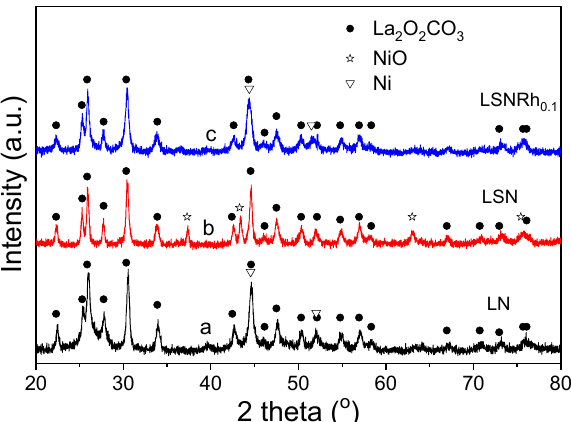
Figure 9. X-ray diffraction patterns of ( a ) LN, ( b ) LSN, and ( c ) LSNRh 0.1 samples obtained after the TPO experiments presented in Figure 8.